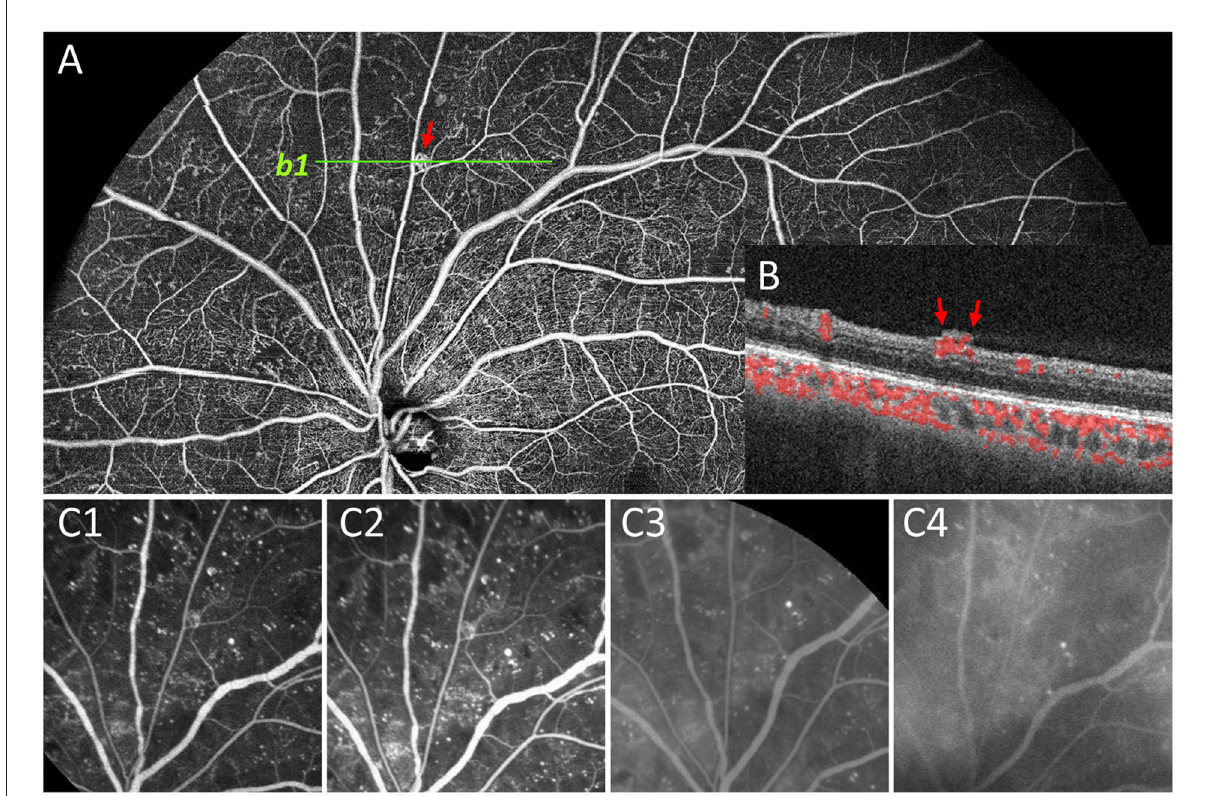
FIGURE4 Representative image to show undetected NVE by FFA. In panel (A) , the NVE above the optic disc (red arrow) was confirmed by OCT B-scan that the lesion had broken through the ILM ( b1 , B ). During the whole FFA process (C1–C4) , no obvious fluorescein leakage was seen in the corresponding lesion compared with the background leakage. Therefore, the lesion was documented as IRMA rather than NVE on